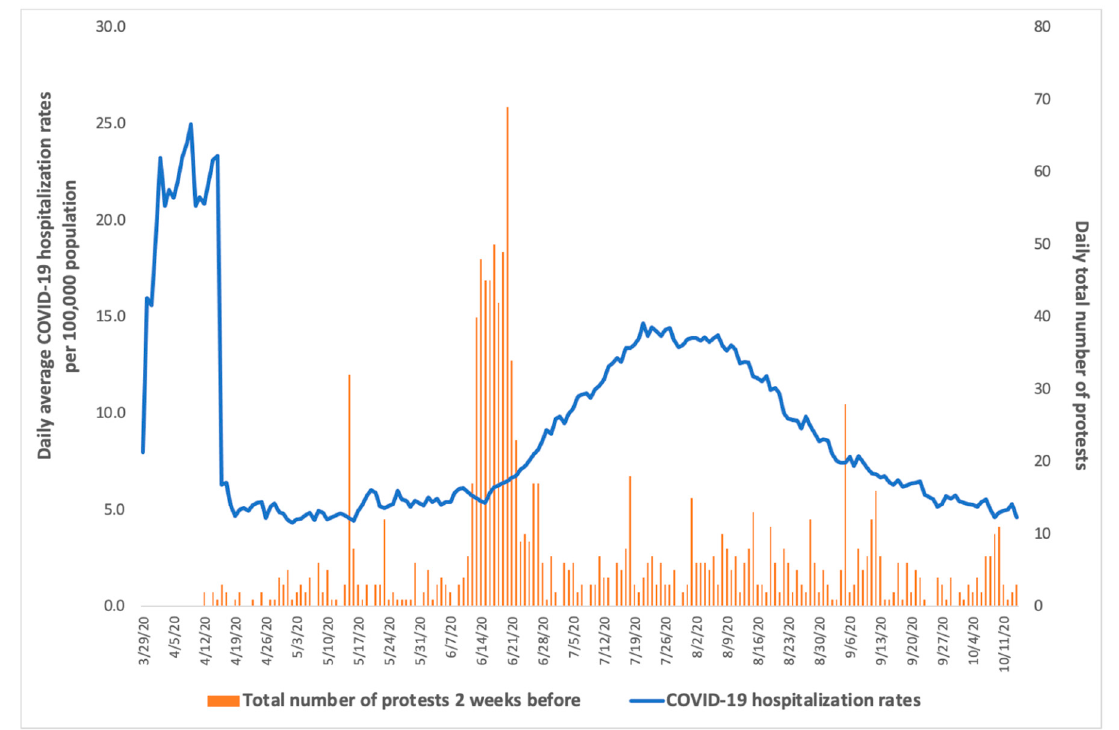
Figure 1. Daily average COVID-19 hospitalization rate per 100,000 population and total number of protests two weeks earlier from 29 March–14 October 2020 across California state counties ( n = 55 counties).